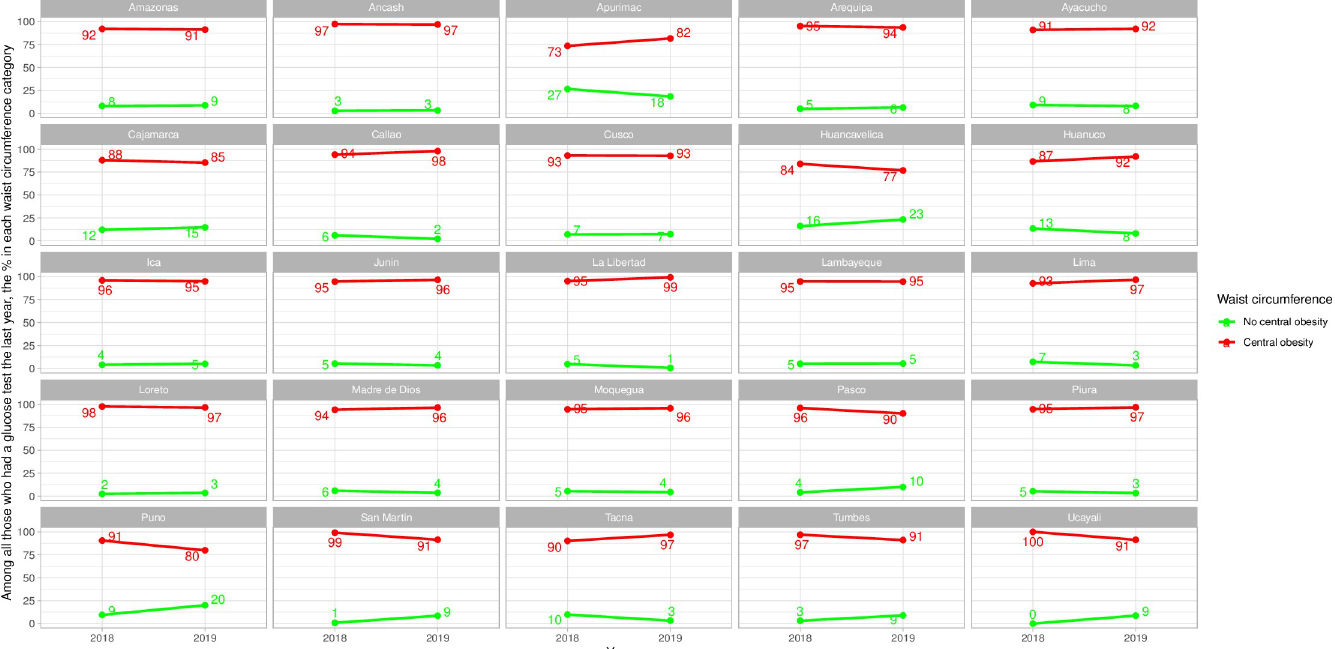
Fig 6. Sub-national time trends of glucose test by waist circumference categories in women.